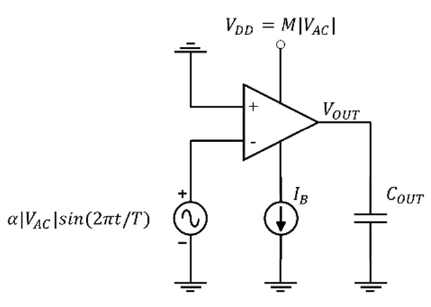
Figure 3. The schematic diagram of comparator delay analysis.